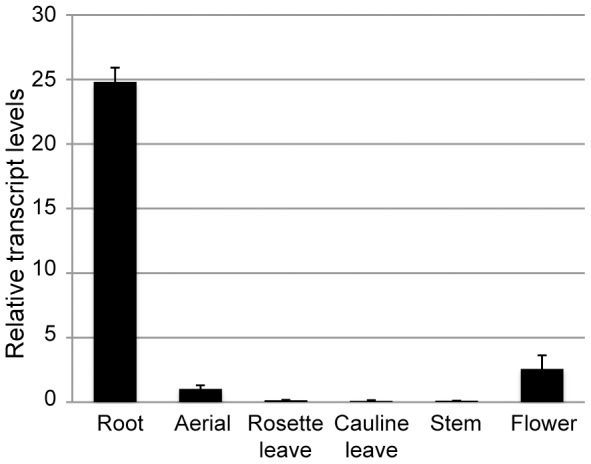
PIZ is expressed in various tissues in Arabidopsis.Transcript levels of PIZ in roots (Rt), aerial tissues (Ae), rosette leaves (RL), cauline leaves (CL), stems (St) and flowers (Fl) from wild-type plants. Mean values of three biological replicates are normalised to ACT2.